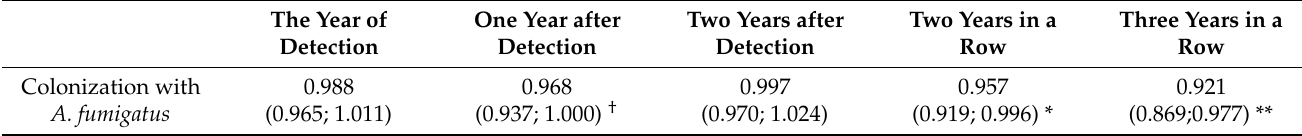
Table 2. The impact of A. fumigatus colonization on lung function over five different time ranges. The Year of One Year after Two Years after Two Years in a Three Years in a Detection Detection Detection Row Row Colonization Colonization with